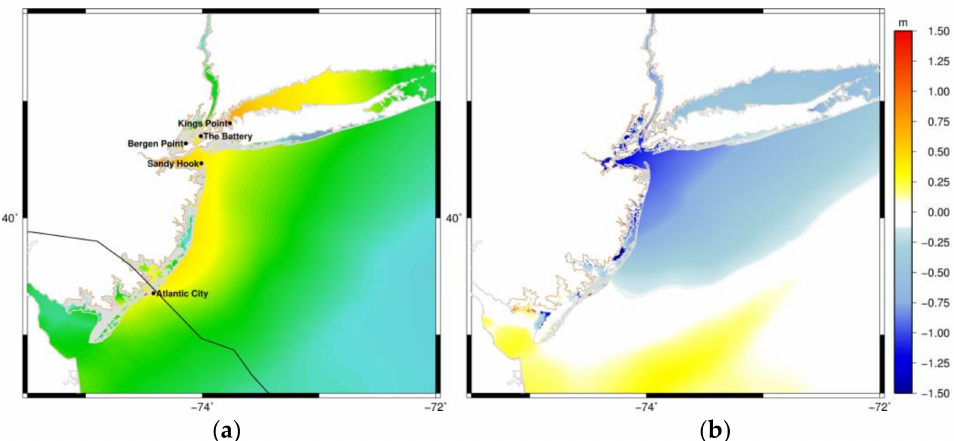
Figure 8. ( a ) Simulated maximum water levels above MSL during the period of 28 October 0000 UTC through 30 October 1200 UTC for SCT12-4. The black line represents the track of the storm, which makes landfall closer to Atlantic City, south of the observed landfall location. ( b ) Difference between SCT12-4 and the control simulation.